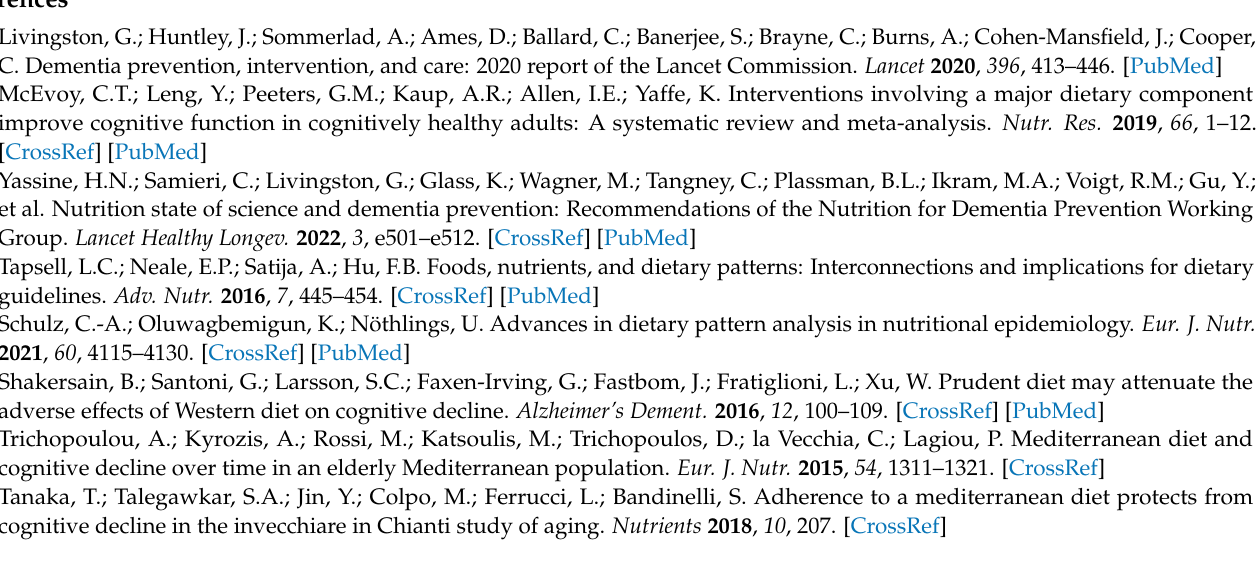
Table S2: Risk of bias assessment for prospective studies; Table S3: Overview of prospective studies examining associations between change in global cognitive function and DPs; Table S4: Overview of prospective studies examining associations between change in global cognitive decline and DPs; Table S5: Overview of prospective studies examining associations between any mild or major cognitive disorder and DPs; Table S6: Overview of intervention studies examining effects of DPs on cognitive outcomes; Table S7: Risk of bias assessment for intervention